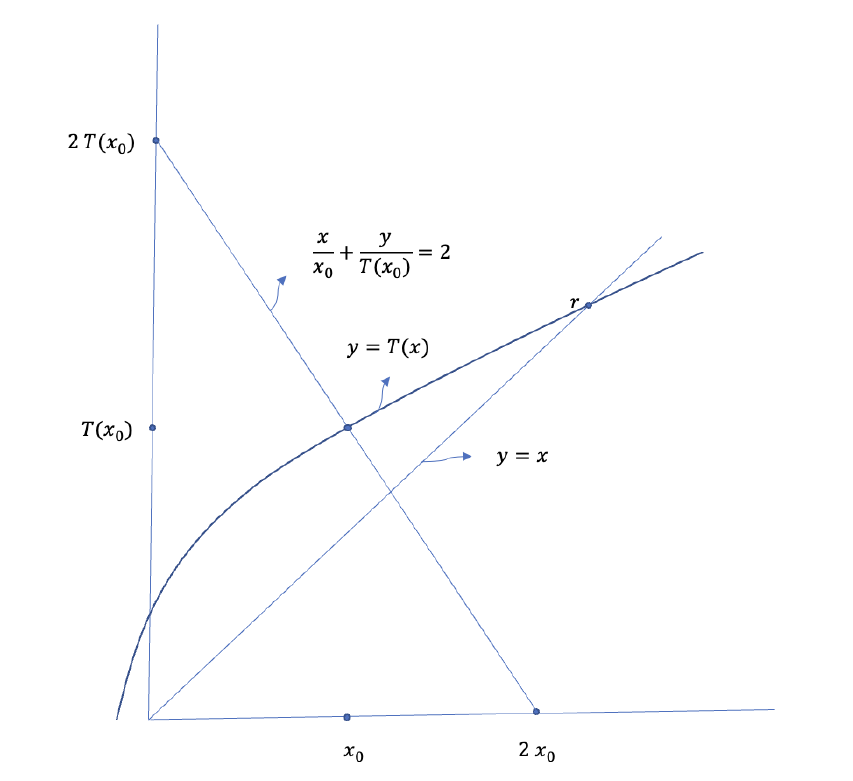
Figure 1. Graph of approximation of nonlinear function y = T ( x ) by a linear